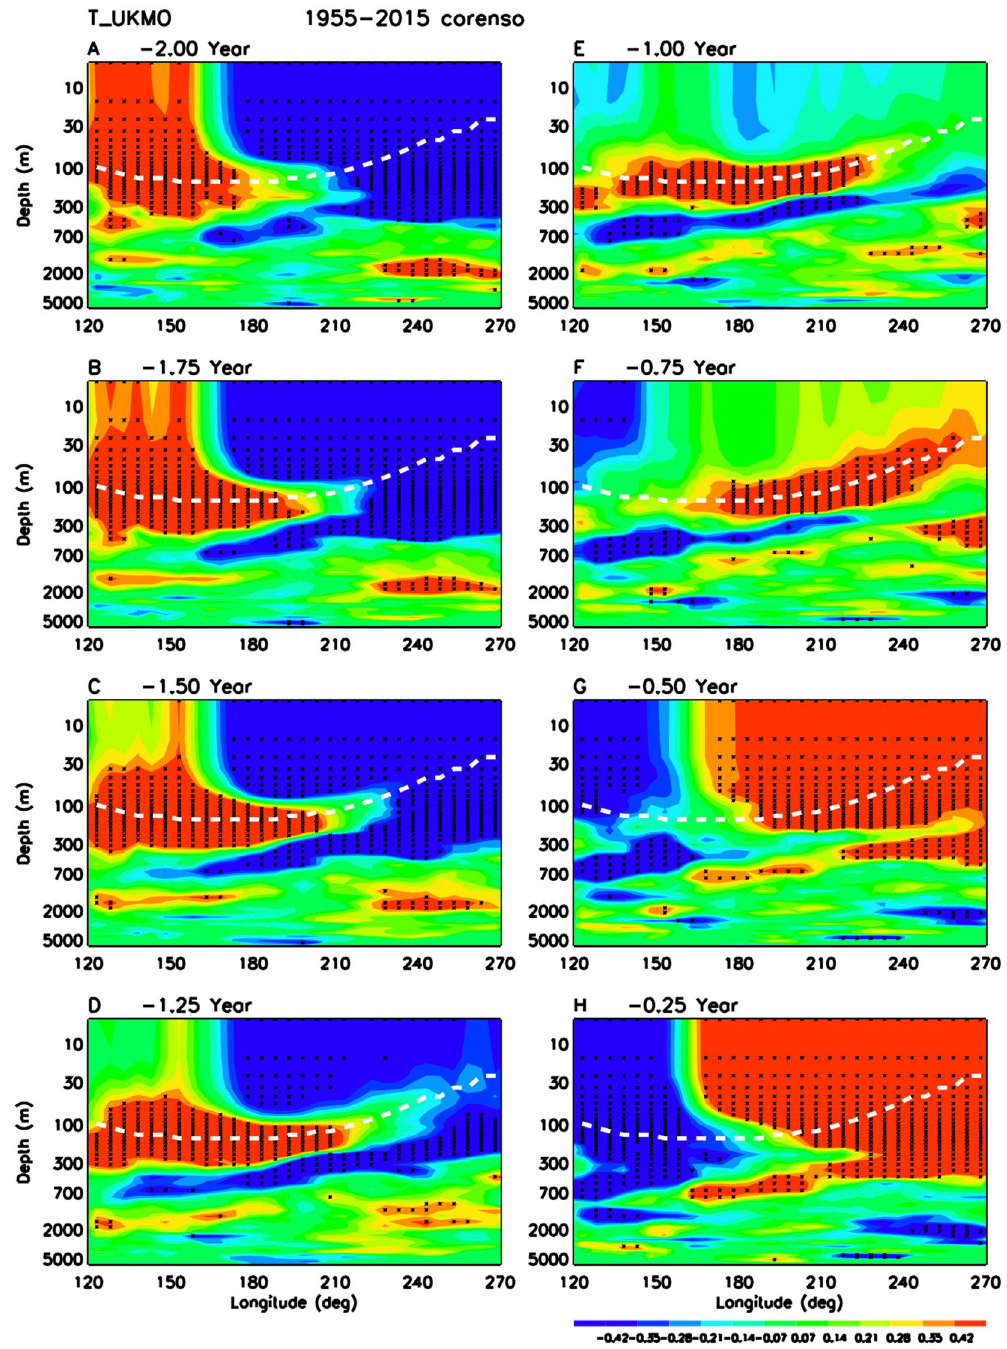
Figure 1. Eastward propagation of ocean subsurface wave leading to switch from La Nina to El Nino. Shadings show lag-correlation of UKMO ocean analysis subsurface temperature along the equator (5N-5S) with Nino3.4 SST from ( A ) − 24 months to ( H ) − 3 months for all ENSO events in 61 years from 1955–2015. Black stars denote the grids with lag-correlation above 95% confidence level. The white dashed line is the climatological 23.5 °C line from Supplementary Fig.